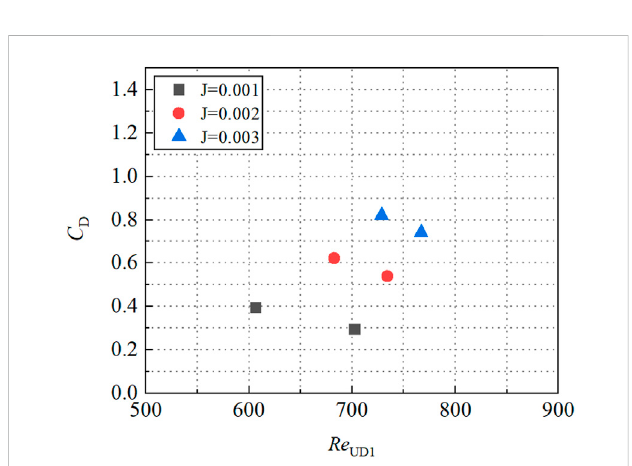
FIGURE 9 Dependence of the C D on the Reynolds number of zone 1A for runs X.